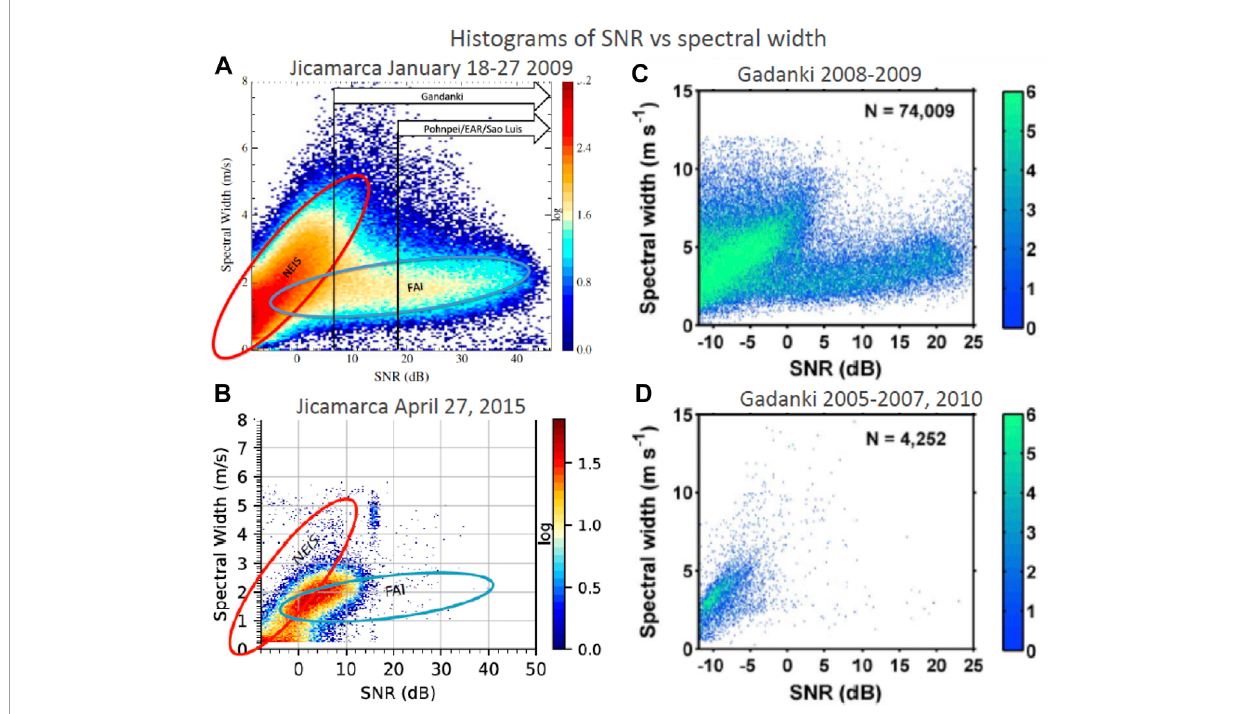
FIGURE 8 Two-dimensional histograms of 150-km echoes based on SNR and spectral width, for Jicamarca (A, B) and Gadanki (C, D) and low (A, C) and moderate (B, D) solar conditions. Two-distinct populations are identified in 2009, while at other years (solar conditions), the type B (FAI) population is less over both sites (adapted from Chau and Kudeki, 2013; Reyes, 2017; Patra and Pavan Chaitanya, 2016, Figures 3, 3.16, 5,